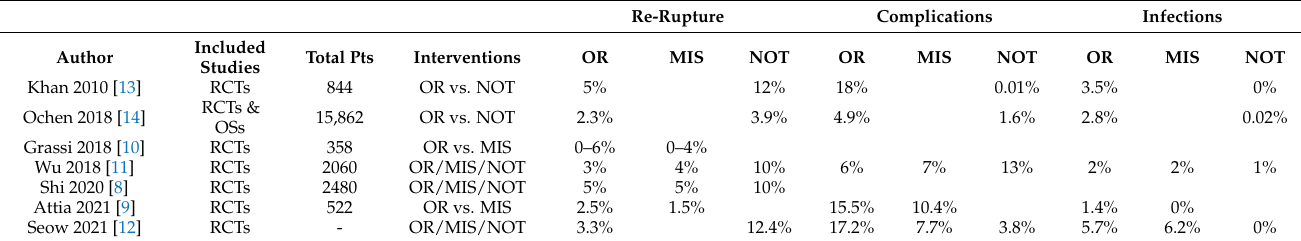
Table legends: OR = open repair; MIS = minimally invasive surgery; NOT = nonoperative treatment. Percentages refer to those reported in the relative study by the